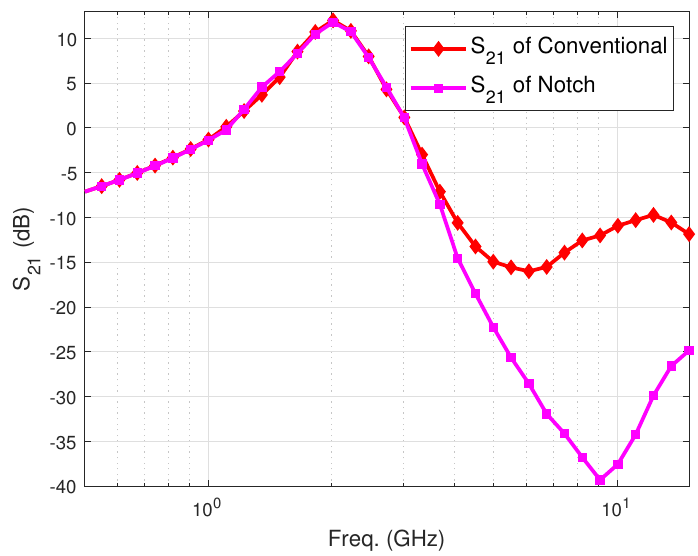
Figure 5. Gain performance of the proposed notch LNA compared to the conventional LNA.